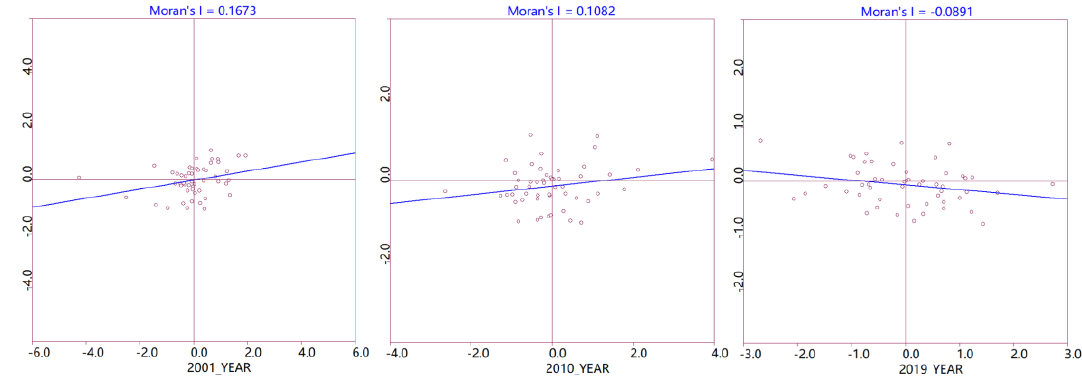
Figure 2. The GISA of urban and rural water shortage risks in Northwest China.